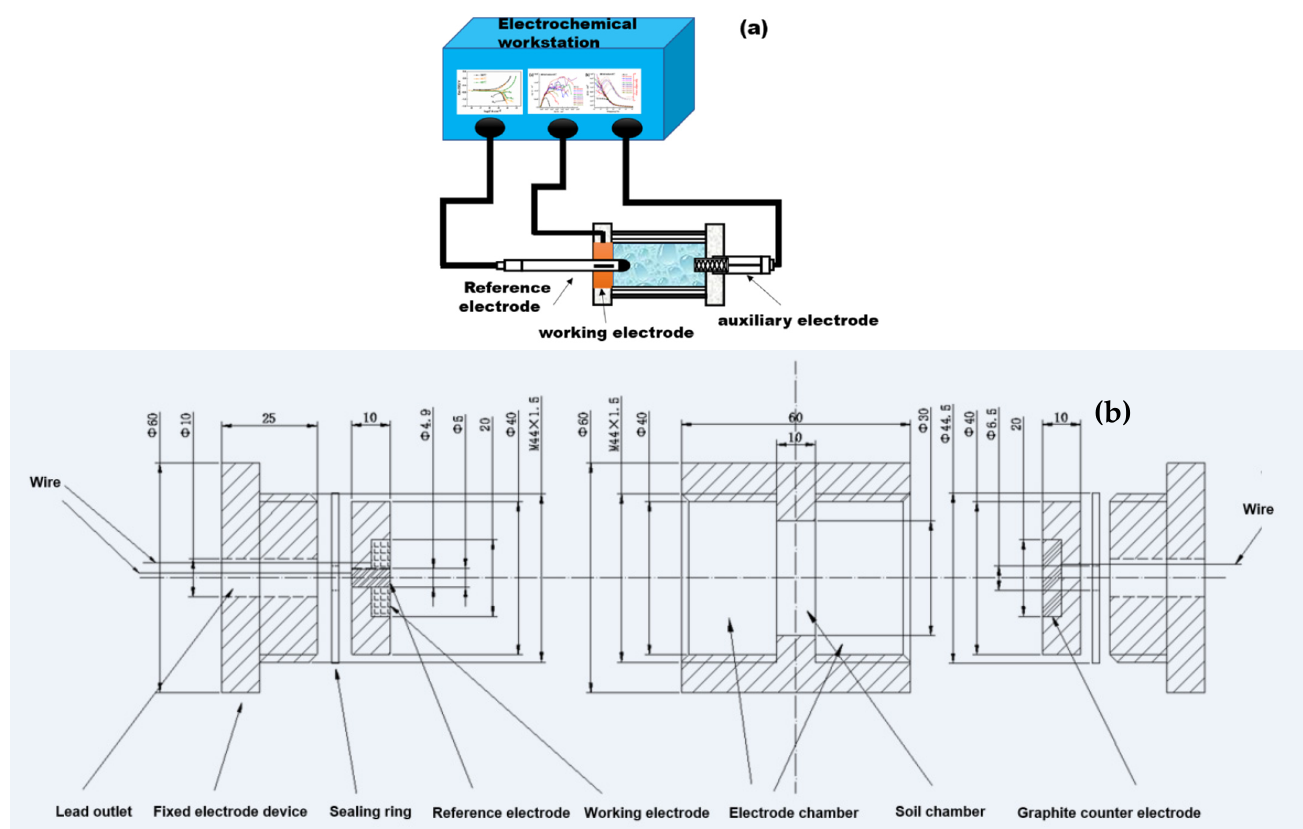
Figure 2. ( a ) Schematic diagram of electrochemical test; ( b ) electrolytic cell designed for electrochemical test.